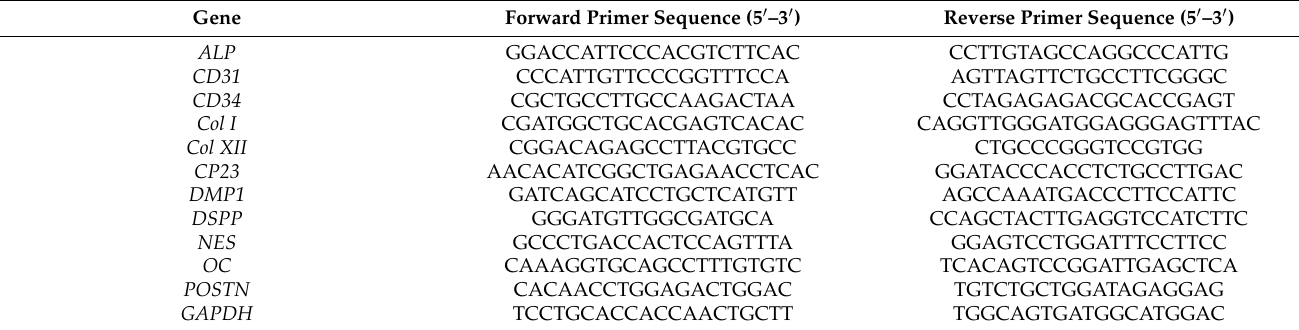
Table 2. qPCR forward and reverse primer sequences. The annealing procedures were performed at 60 ◦ C for all primers. Gene